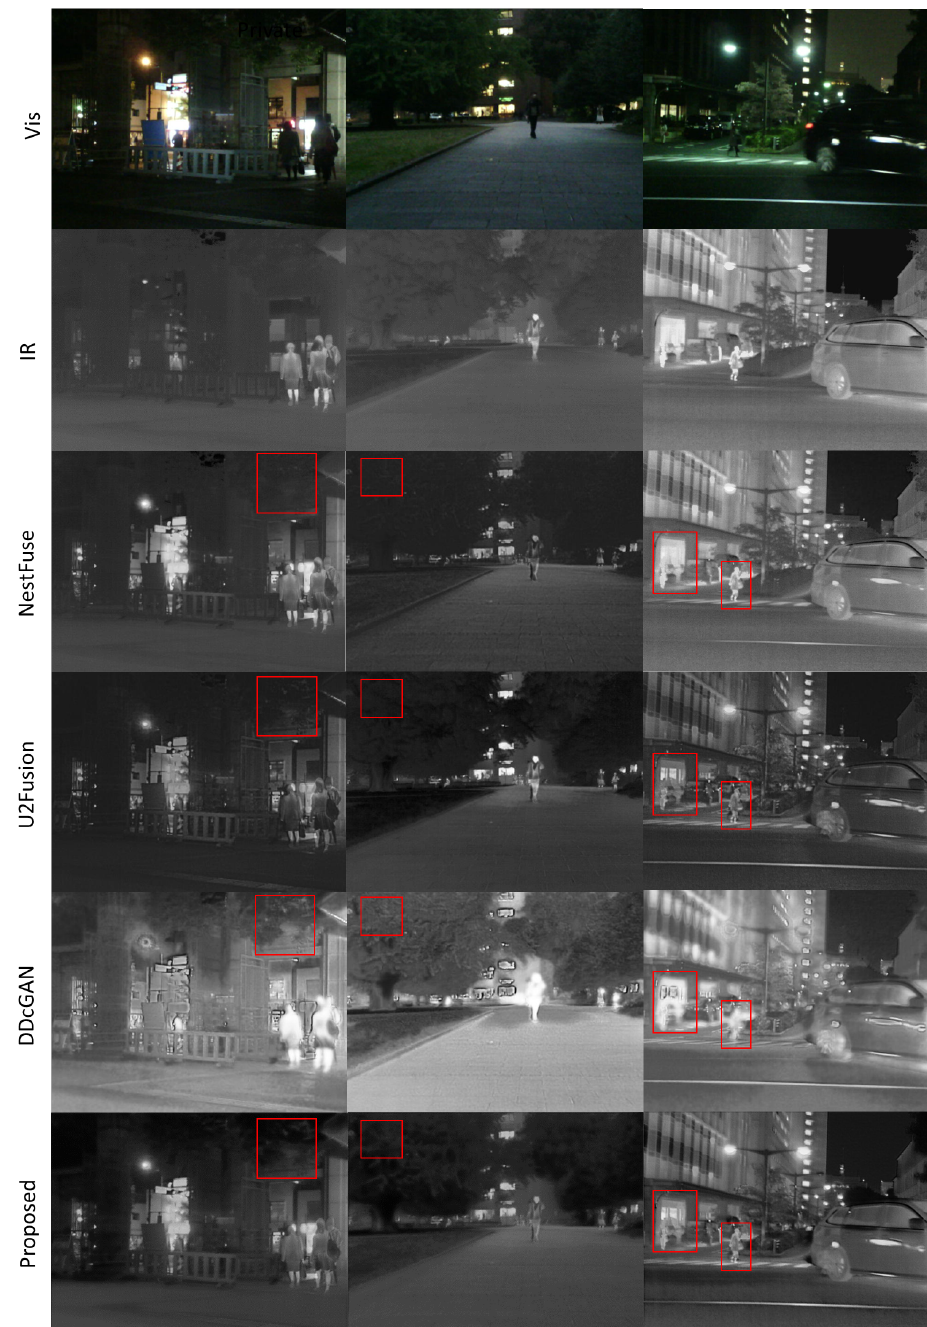
Figure 2. Qualitative comparison of the proposed method with other state-of-the-art methods on image pairs taken from the private dataset. The first row contains visible images. Second row contains infrared images. The last row contains the fused results of our proposed